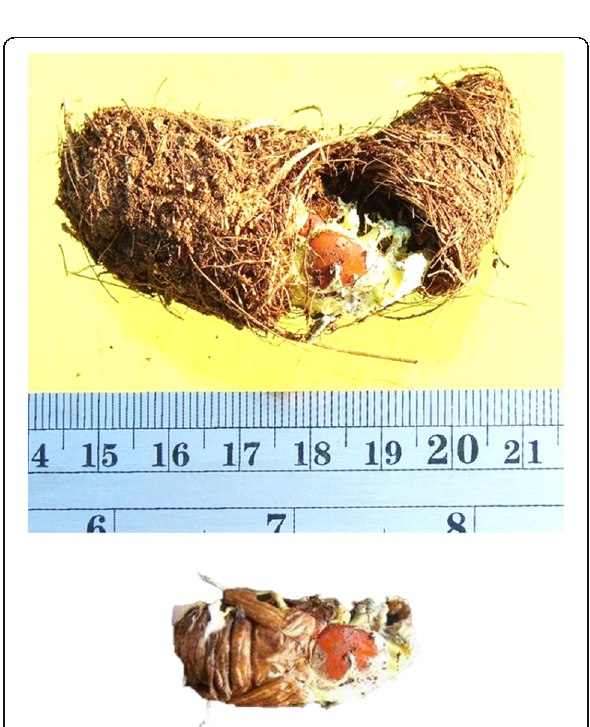
Fig. 1 Dead pupa of RPW R. ferrugineus inside cocoon with developed mycosis after treatment with B. bassiana conidiospores in the larval stage